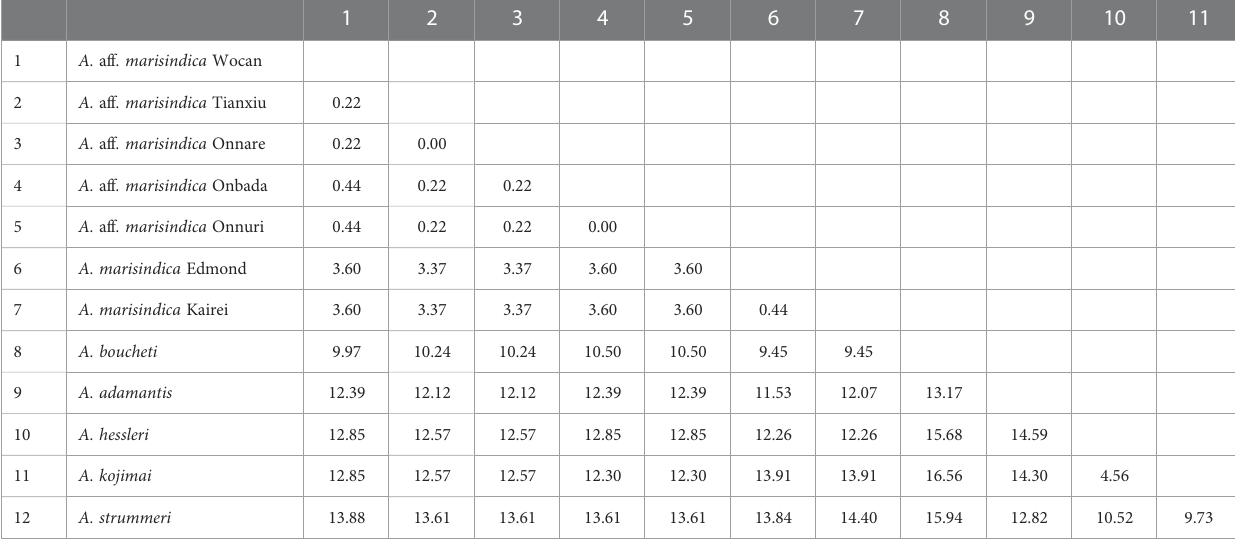
TABLE 3 Pairwise genetic distance (%) of mtCOI sequences (459 bp) of A. aff. marisindica with other Alviniconcha species based on Kimura 2 parameter